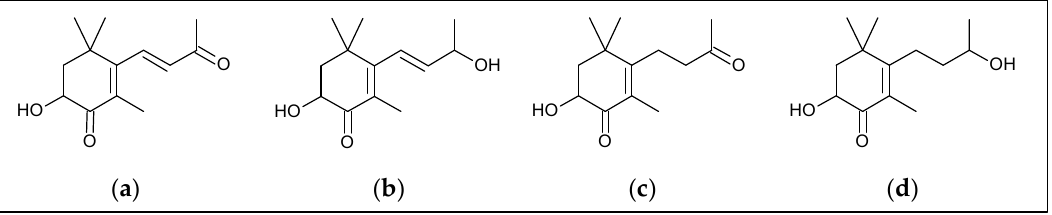
Figure 3. Molecules generated through the catabolism of astaxanthin in humans [31]. ( a ) 3-hydroxy- 4-oxo- β -ionone; ( b ) 3-hydroxy-4-oxo- β -ionol; ( c ) 3-hydroxy-4-oxo-7,8-dihydro- β -ionone; ( d ) 3-hydroxy- 4-oxo-7,8-dihydro- β -ionol.